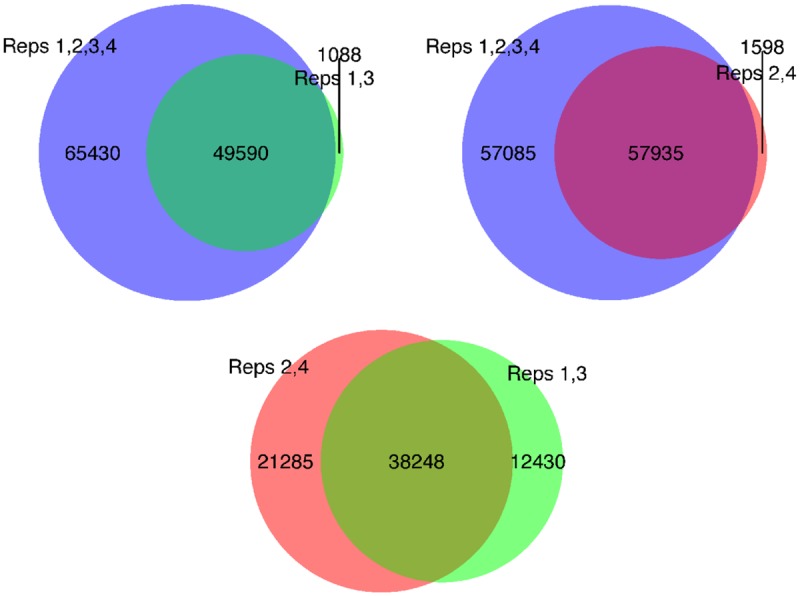
Effect of number of replicates on 5hmC detection.Top left: Number of probes detected as differentially methylated, i.e. as hydroxymethylated (having a positive 5hmC signal), with all four replicates and with only replicates 1 and 3. Top right: Using only replicates 2 and 4. The number of probes observed in two replicates but not in four fall within the expected 1% FDR. Bottom: Probes with 5hmC in pair 1 and 3 compared to pair 2 and 4. Only 38,246 probes were observed in both pairs.